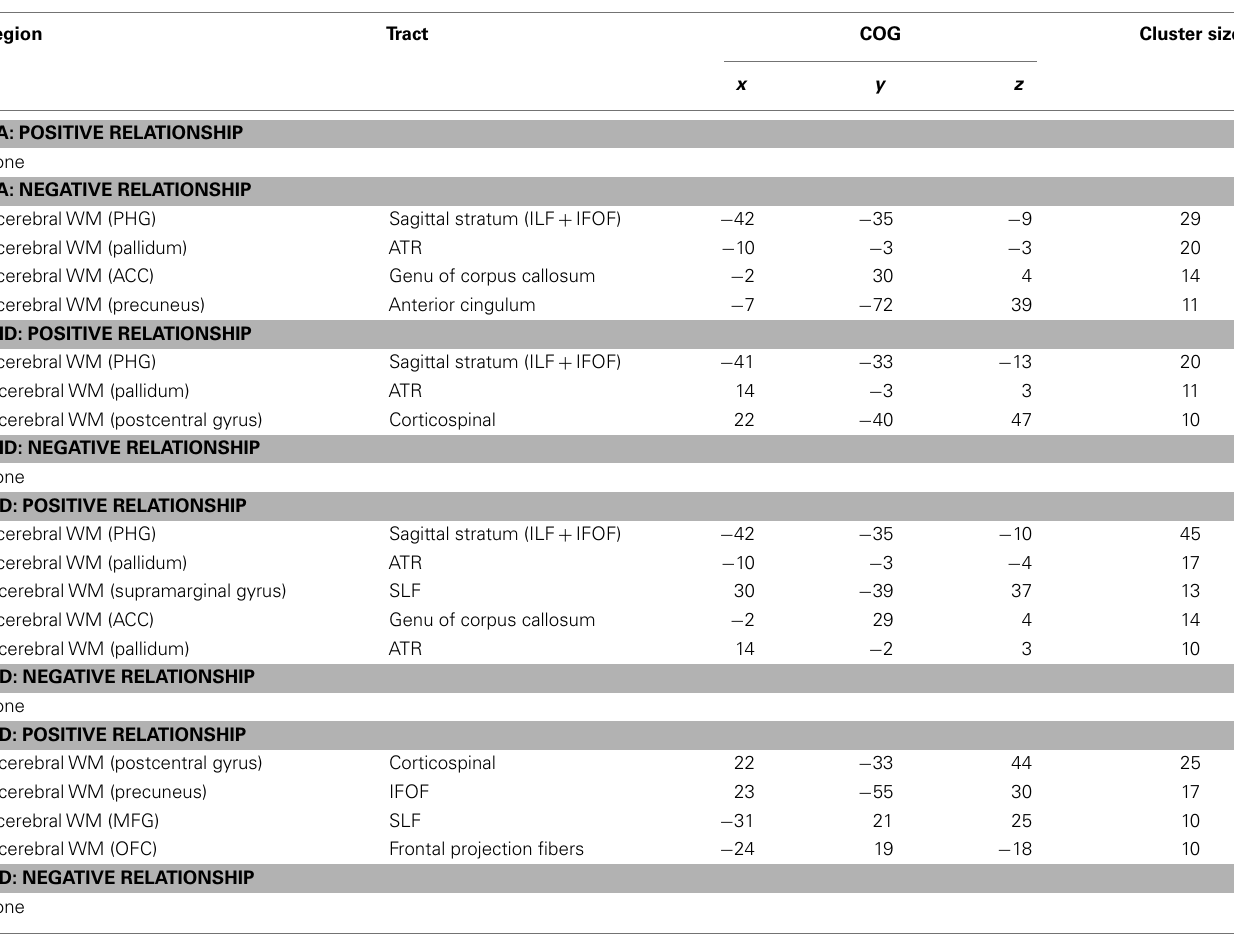
Table 3 |Voxel-wise correlations with depression severity (CDRS-R). Region Tract COG Cluster size